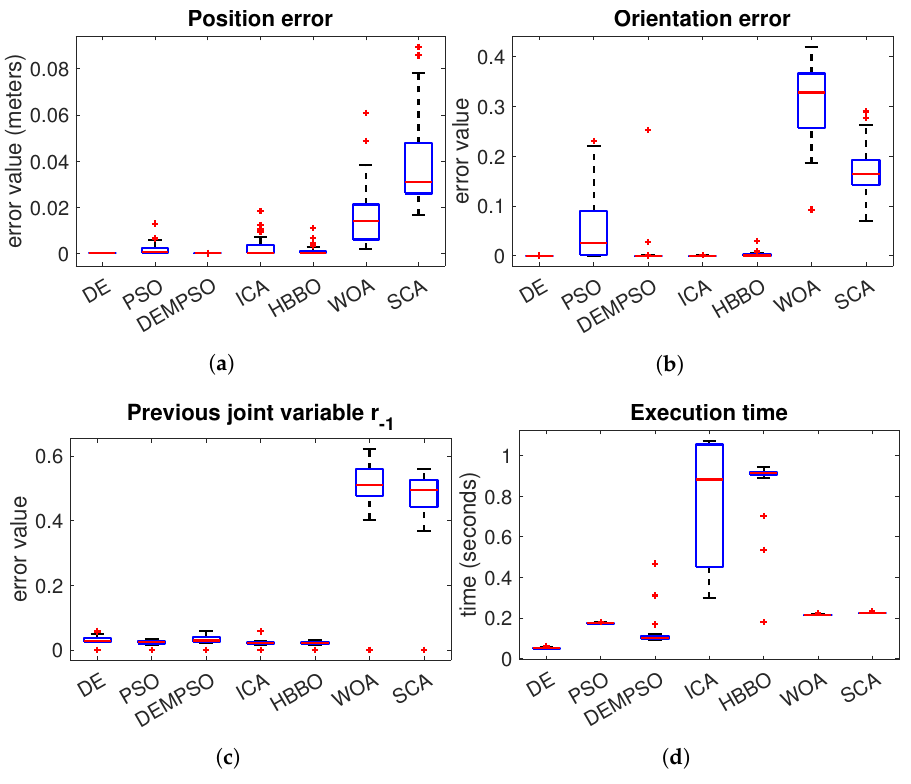
Figure 5. Circle path tracking results for the Puma robot. ( a ) Puma end-effector position error (5); ( b ) Puma end-effector orientation error (15); ( c ) Puma joint variables error (16); ( d ) Execution time for each point in the